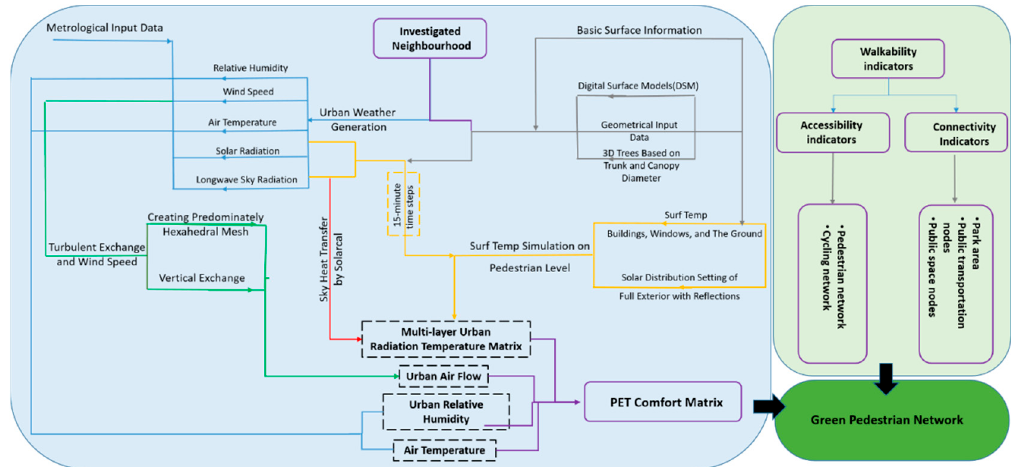
Figure 2. The methodology of City Digital Twin for Green Pedestrian Network .